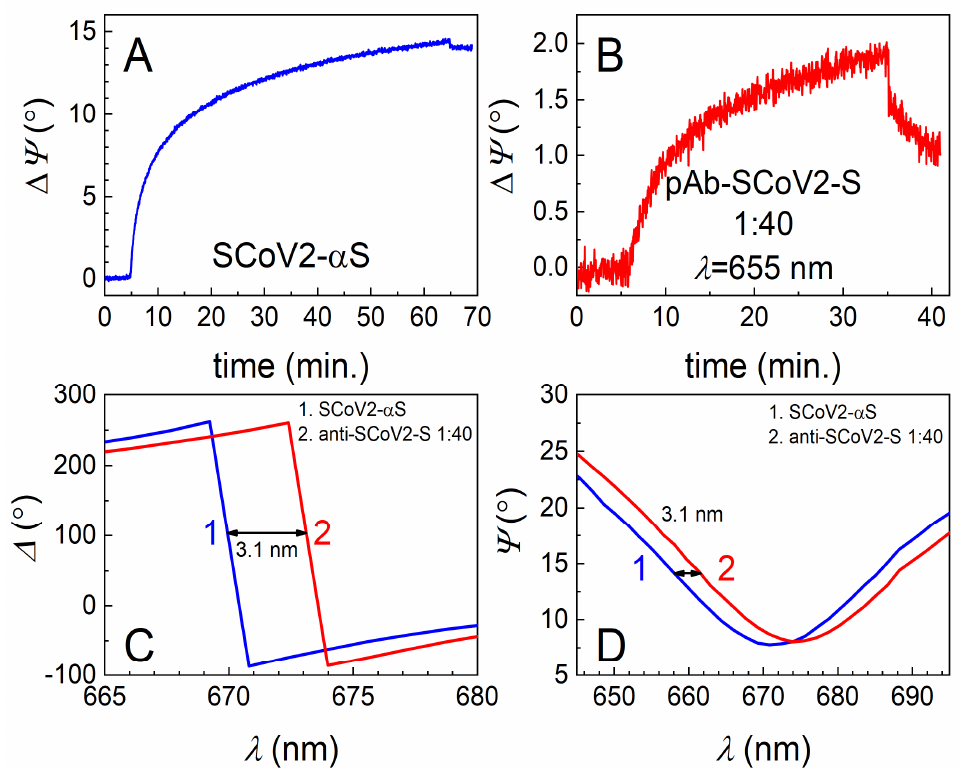
Figure 3. Time-resolved TIRE kinetics and ellipsometric parameters of SCoV2- α S immobilization and interaction with specific polyclonal antibodies. ( A ) Kinetics of covalent SCoV2 α -S immobilization on 11-MUA SAM modified gold-coated SPR sensor disc; ( B ) kinetics of polyclonal antibody interaction with covalently immobilized SCoV2- α S at 1:40 dilution of serum; ( C ) ∆ and ( D ) Ψ spectral shift after immune complex formation using the same dilutions of polyclonal antibodies.